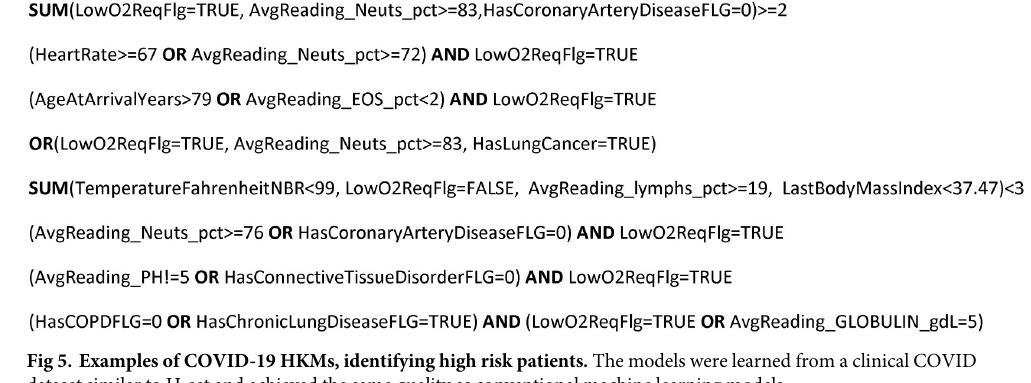
Fig 5. Examples of COVID-19 HKMs, identifying high risk patients. The models were learned from a clinical COVID dataset similar to H-set and achieved the same quality as conventional machine learning models.